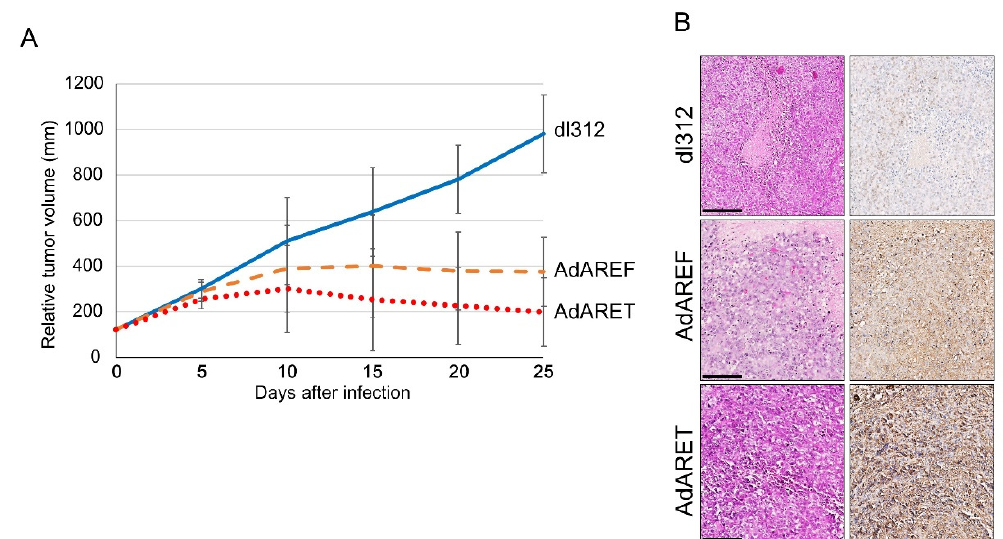
Figure 4. In vivo antitumor effects of intratumorally injected AdARET and AdAREF in HeLa xenograft nude mice. ( A ) HeLa cells were injected subcutaneously into nude mice to form a tumor with a diameter of approximately 5 mm (after approximately 3 weeks). 10 9 vp (100 µL) of dl312, AdARET and AREF were injected intratumorally into the tumor on days 1 and 4. At least five mice were used for each group. Tumor volumes were measured twice a week and the results obtained are shown as the mean of relative volumes ± SD. ( B ) H&E and immunohistochemistry staining of HeLa S3 tumors treated with dl312, AdARET and AdAREF in deparaffinized section. Adenovirus detection (brown precipitation) was performed by immunostaining using anti-adenovirus antibody in all viruses injected tumors. Scale bar indicates 100 µm.